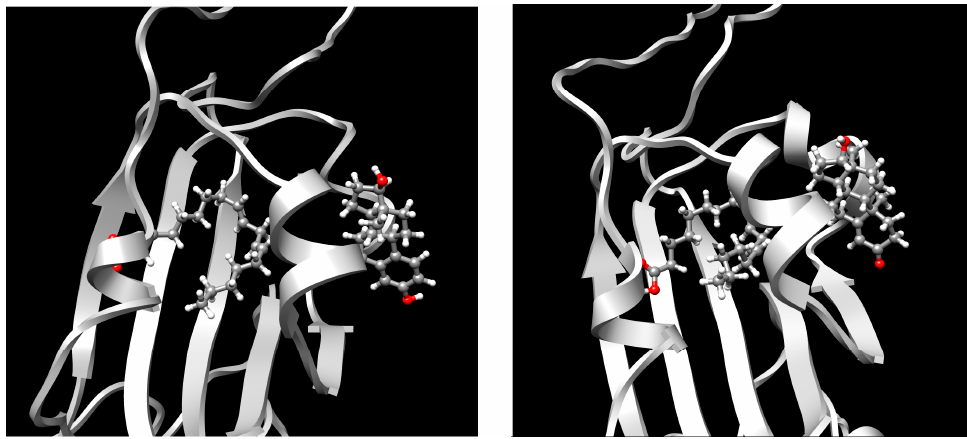
Figure 5. Cooperative binding of testosterone ( left ) and estrogen ( right ) with FABP in the presence of bound LA (overlaying beta strands). Hormones are to the right of the right-hand spike helix. This result suggests that synergistic binding of LA (and by implication other fatty acids) with estrogen and testosterone potentially creates more effective locking of the spike in the closed form. We found no significant univariate or multivariate relationships between log P(oc- tanol/water) (lipophilicity), number of hydrogen bond donors and acceptors, and number of rotatable bonds (flexibility) of FABP ligands and their binding energies (Tables S1 and S2).